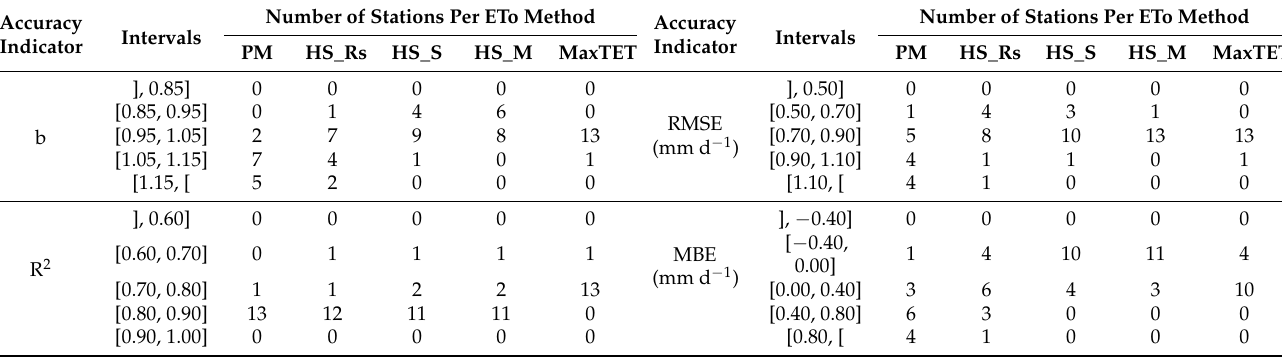
Table 3. Distribution of the statistical accuracy indicators when comparing daily ETo estimated from raw (non-bias-corrected) NASA POWER data with ETo-PM estimated from observed weather data relative to all